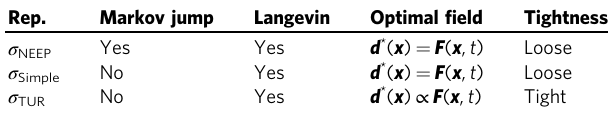
Table 1 A summary of the comparison between the different variational representations considered in this work. σ NEEP is the Neural Estimator for Entropy Production (NEEP) representation (Eq. (9)), σ Simple is the simple dual representation (Eq. (10)), and σ TUR is the thermodynamic uncertainty relation (TUR) based representation (Eq. (8)). They have different applicabilities to Markov jump processes and Langevin dynamics. The optimal coef fi cient fi eld d * ( x ) that maximizes a variational representation is equivalent to or proportional to the thermodynamic force F ( x , t ). The TUR representation is the tightest as shown